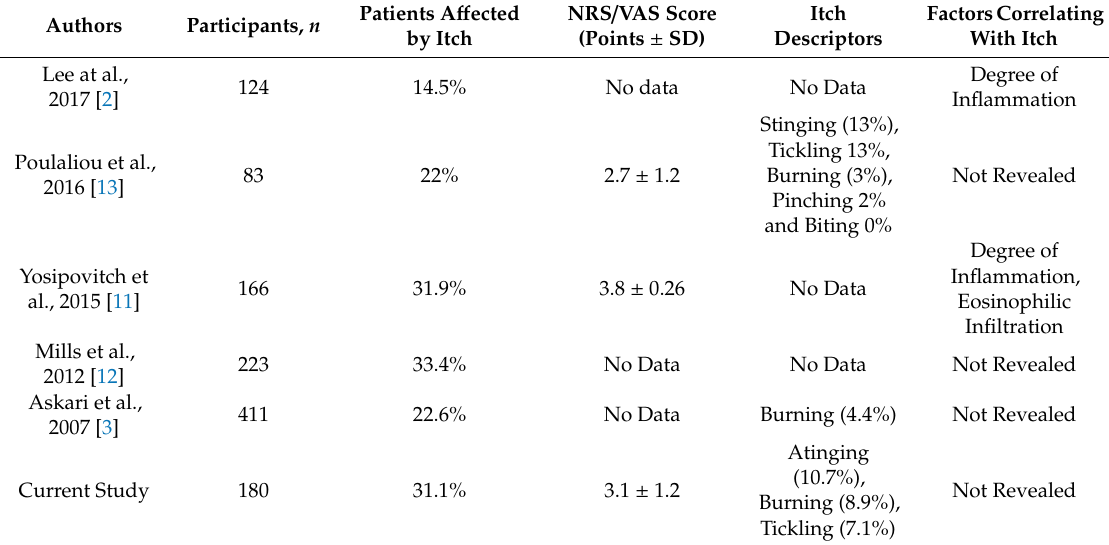
Table 2. Comparison of basal cell carcinoma-associated itch among series of published